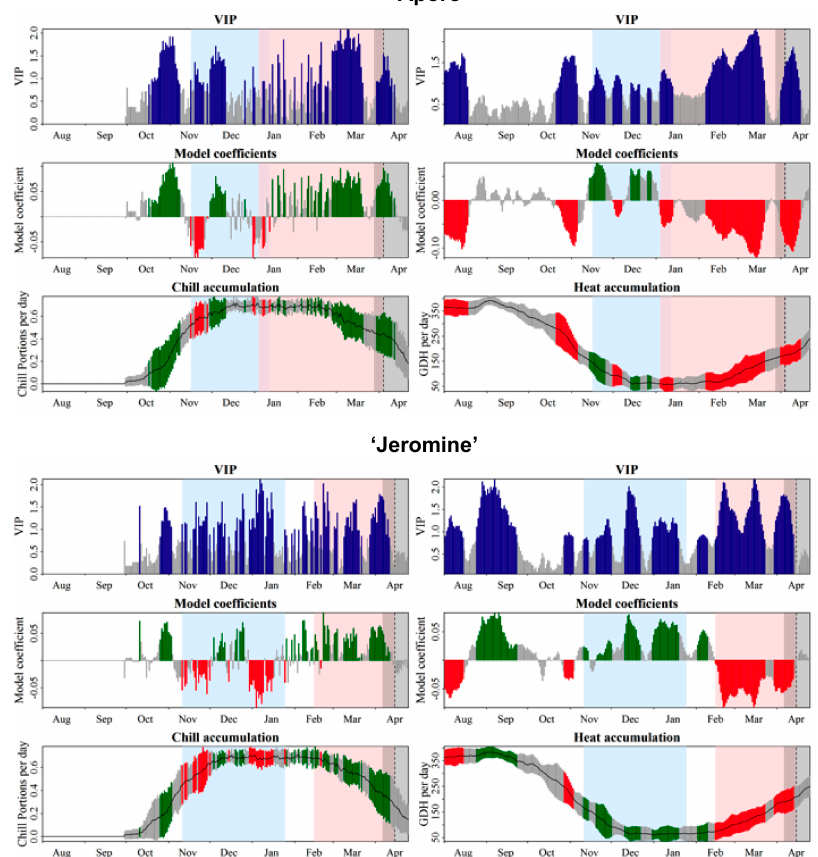
Figure 4. Results obtained from the PLS regression analysis between blooming dates and daily mean chill and heat accumulation for ‘Aporo’ and ‘Jeromine’ in Mas Badia using the dynamic model and the GDH model. See the caption in Figure 3 for the full explanation, except for the dotted line, which marks the median date of all the blooming dates recorded from 1992 to 2018 Establishing the chilling phase for this species was easier than for almond as continuous high VIP values and negative coefficients were persistent along the phase. However, the end of the chilling